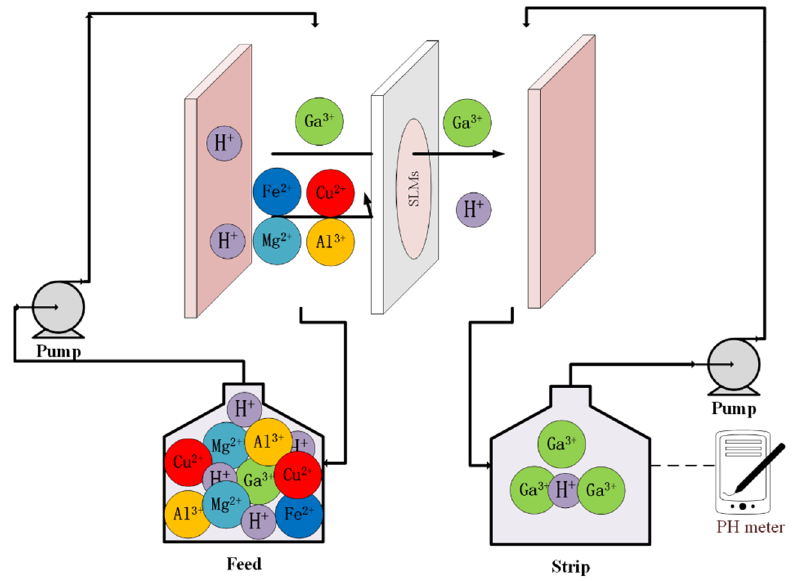
Figure 1. Schematic illustration of the SLM device.